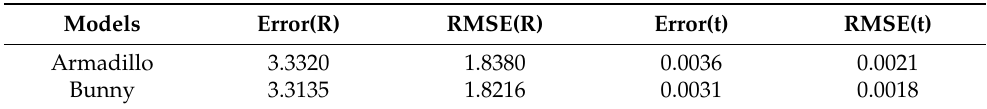
Figure 5. Visual registration results. Red, green, and blue denote the target point cloud, source point cloud, and predicted point cloud, respectively, and ( a1 , b1 ) indicate the initial positions, while ( a2 , b2 ) denote corresponding registration results. Table 7. Quantitative registration results.